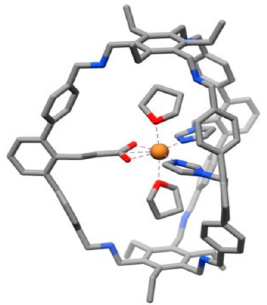
Figure 15. Structural and functional mimic of the pMMO Cu C site. Adapted with permission from (Bete et al., 2022) [132]. Copyright 2022 Wiley.